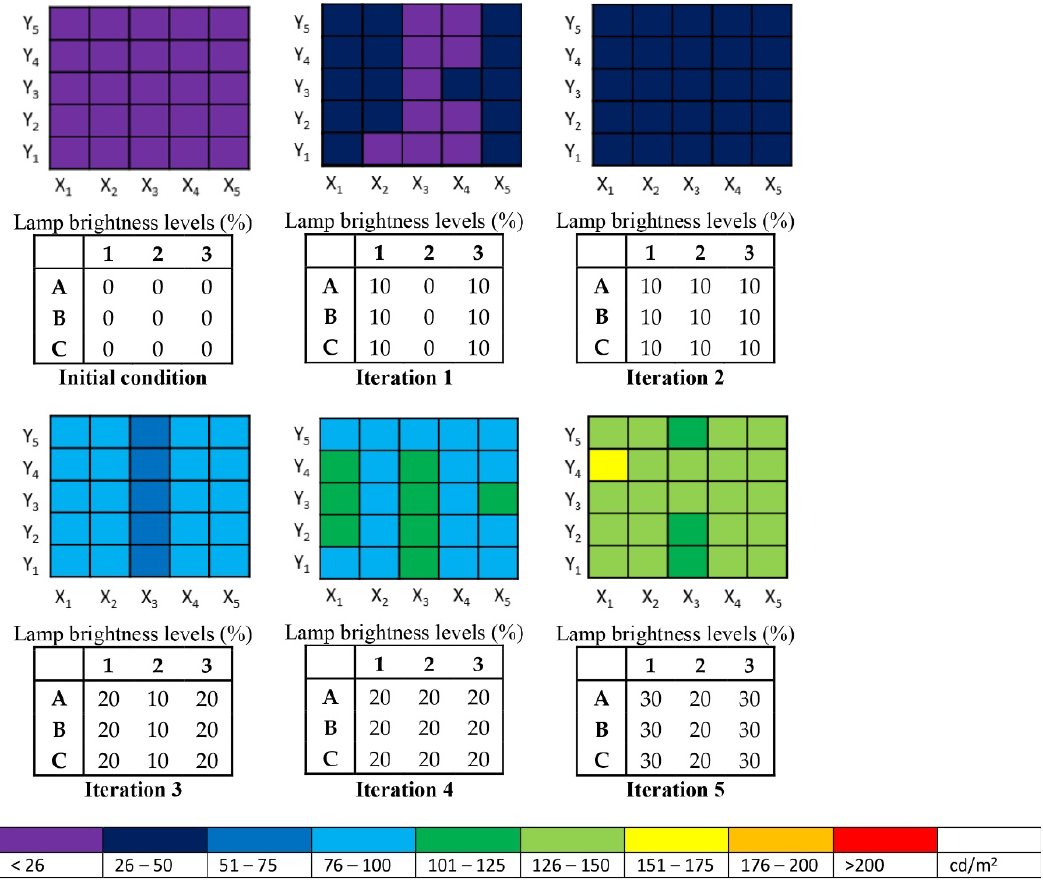
Figure 9. The luminance values and lamp brightness levels for Measurement Scheme